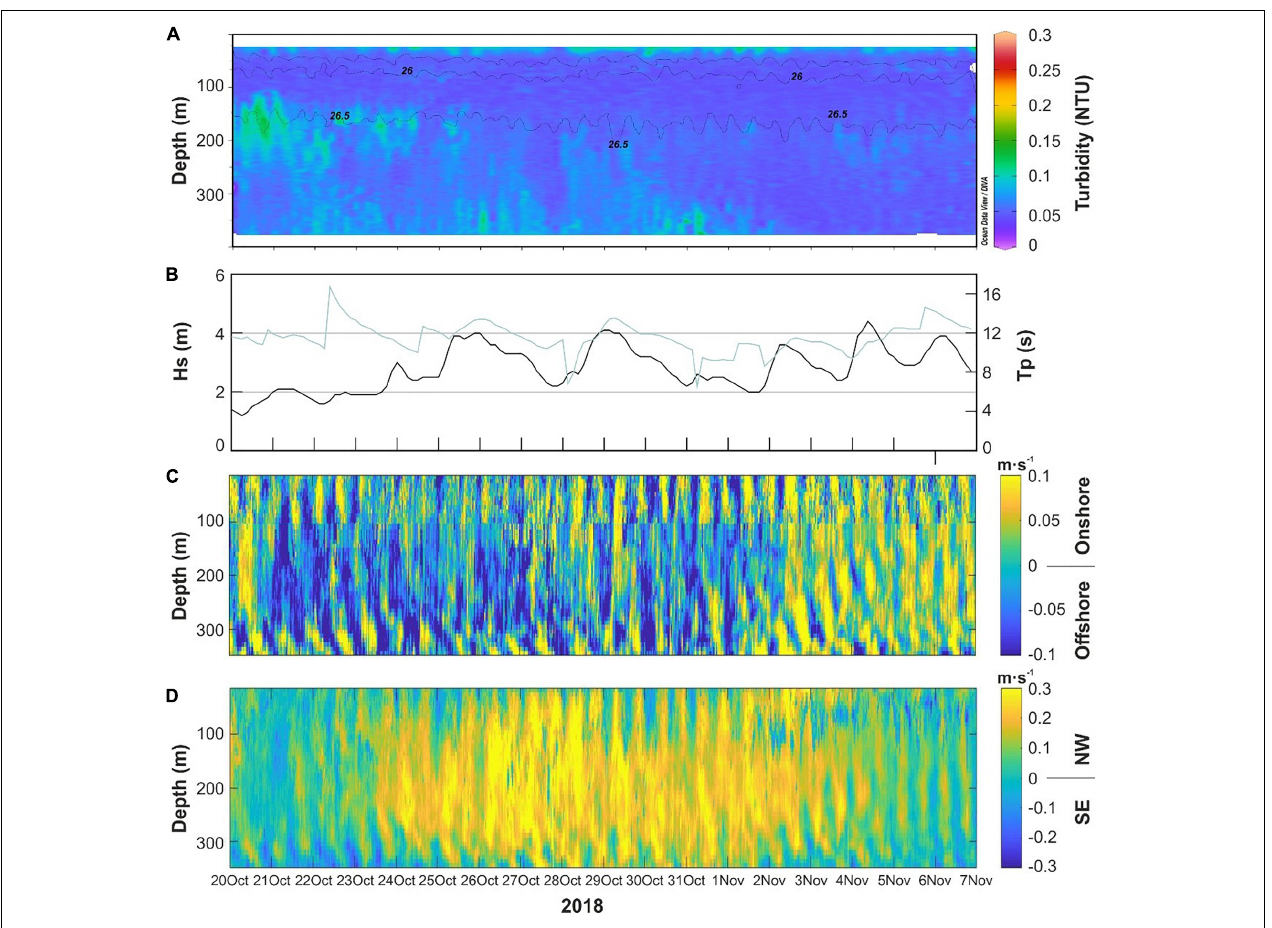
FIGURE 8 | Temporal and spatial distribution during the more intense stormy period of fall 2018 of (A) turbidity in NTU, (B) significant wave height ( Hs ) (black line) and mean wave period ( Tp ) (light blue line), (C) across-margin velocity component, and (D) along-margin velocity component, in m · s – 1 , measured with the 75 kHz Acoustic Doppler Current Profiler (ADCP) installed at the BUS Instrument platform. Note the change in scale for the along-margin component. For interpretation of the references in this figure legend, the reader is referred to the web version of this